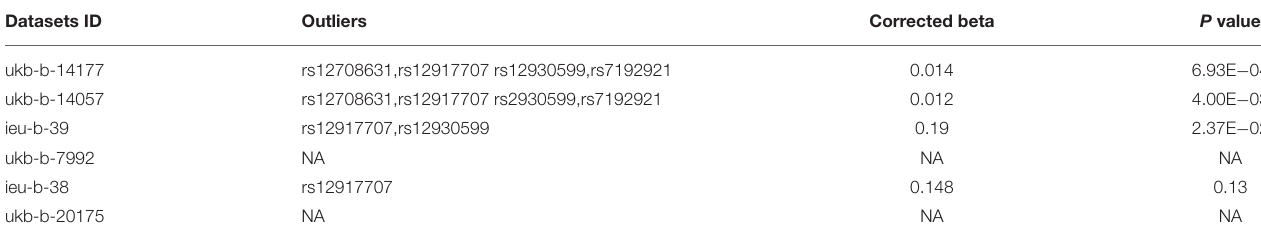
TABLE 2 | Outcomes of Mendelian Randomization Pleiotropy RESidual Sum and Outlier